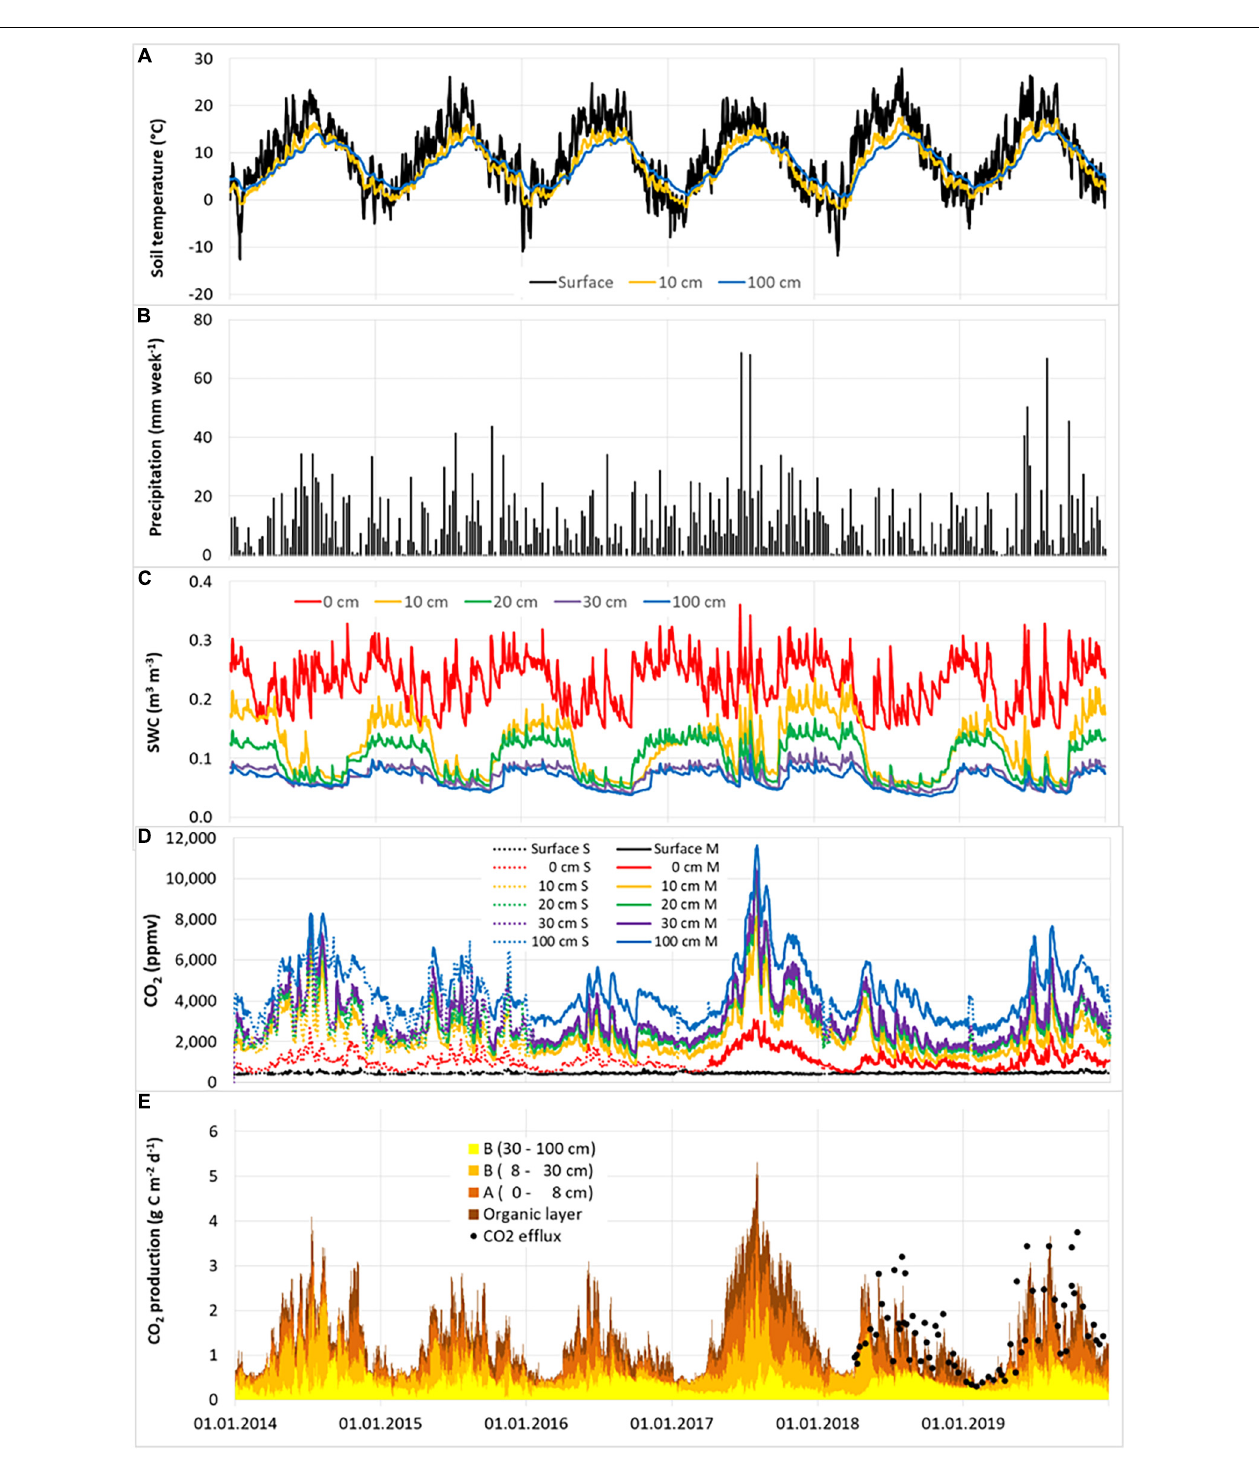
FIGURE 1 | Weekly precipitation total (B) and daily averages of soil temperature (A) , soil water content (SWC) (C) , measured (solid lines) and gap-filled (dotted lines) soil CO 2 concentration (D) , and soil CO 2 production rate, including CO 2 efflux from chamber measurements (E) at different soil depths at the beech site for the years 2014–2019. Total of CO 2 production over all the soil layers corresponds to the CO 2 efflux from the soil surface. Note that the measurement refers to the respective time of the day, while the calculated values represent daily averages. For this reason, part of the deviations between measured and calculated efflux rates is due to the deviating time scale.